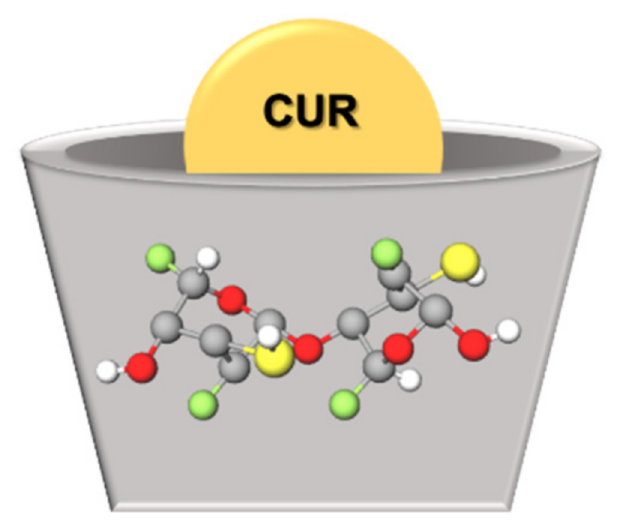
Figure 5. Schematic representation of CUR in